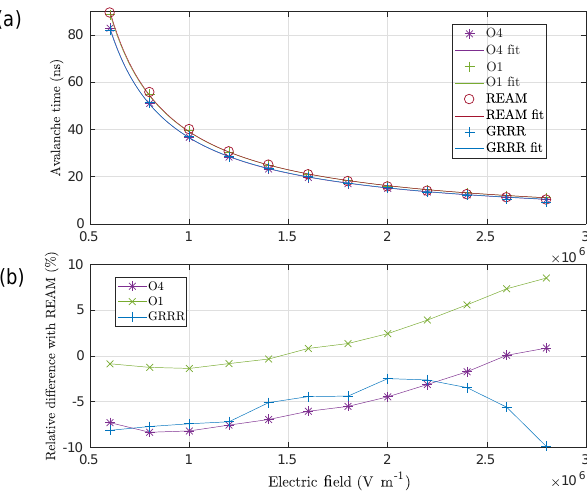
Figure 3. (a) Avalanche multiplication length as function of ambi- ent electric field for each of the codes included in this study. (b) The relative difference of all other models with respect to REAM. Ta- ble 1 indicates the values of the fit parameters.